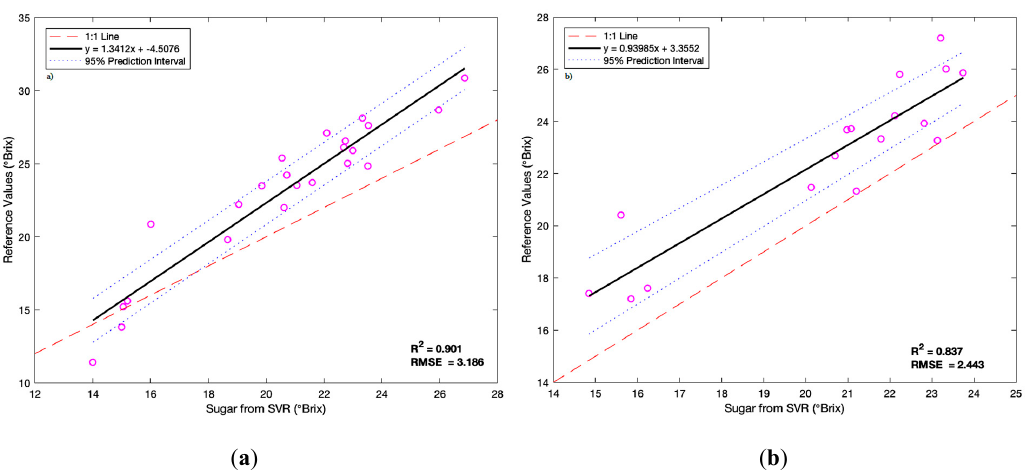
Figure 7. Results for the estimation of the sugar content in the external test sets to further study the generalization capacity; ( a ) TB 2013 samples; ( b ) TN 2013 samples. generalization capacity; ( a ) TB 2013 samples; ( b ) TN 2013